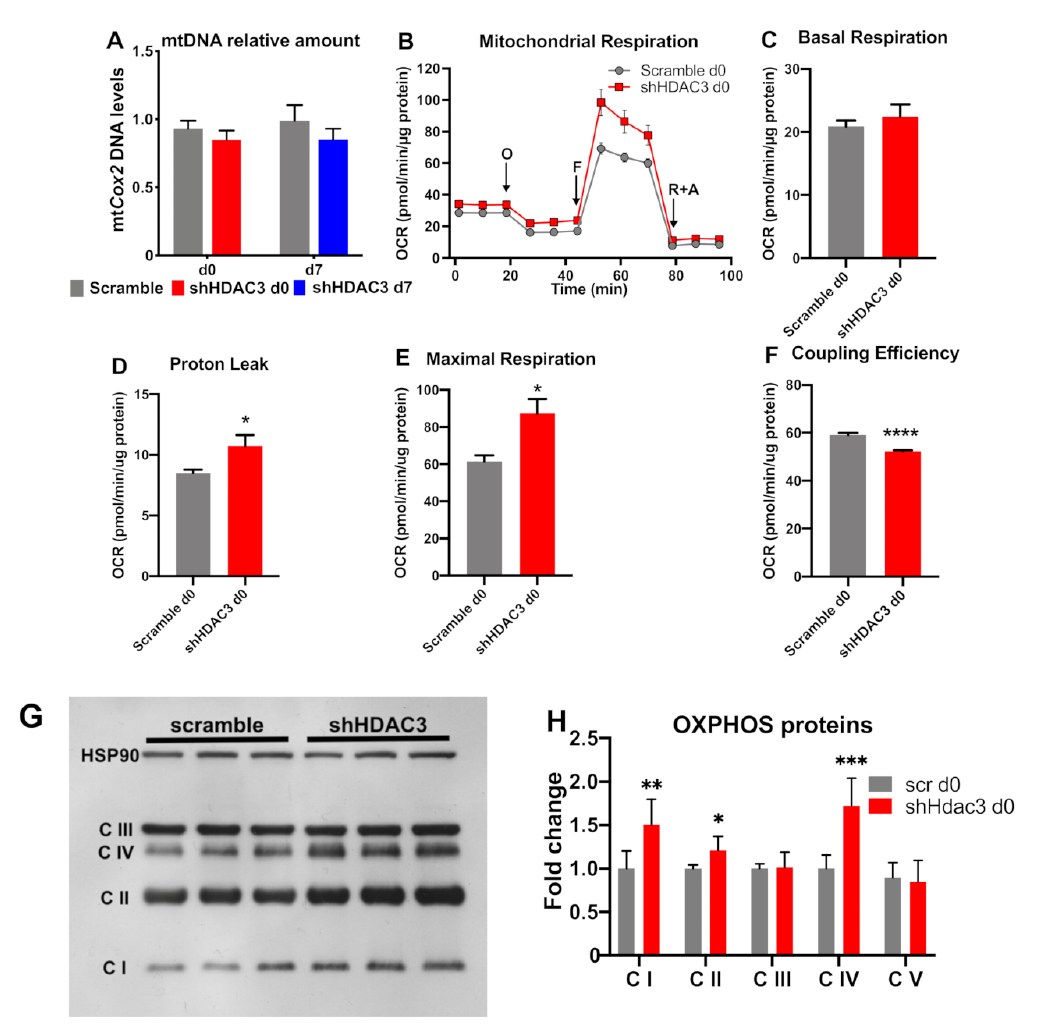
Figure 7. mtDNA levels and mitochondrial respiration in C3H/10T1/2 adipocytes infected with scramble/shHDAC3. ( A ) Cells silenced at day 0 were harvested at day 9 after induction of differentiation, while cells silenced at day 7 were harvested at day 11 after induction of differentiation ( n = 18 from 6 independent experiments). Cells silenced at day 0 were analyzed at day 9 after induction of differentiation for mitochondrial respiration (O, oligomycin addition; F, FCCP addition; rotenone + antimycin A addition) ( B ); basal respiration ( C ), proton leak ( D ), maximal respiration ( E ) and coupling efficiency ( F ) were calculated. Data are presented as mean ± SEM. Statistical analyses were performed with GraphPad PRISM and unpaired Student’s t -test, * p < 0.05 and **** p < 0.0001 ( n = 5). ( G ) Representative western blot of C3H/10T1/2 cells infected with scramble/shHDAC3 at d0 of differentiation to adipocytes to detect OXPHOS proteins: C I, complex I; C II, complex II; C III, complex III; C IV, complex IV; complex V (ATP synthase) was visible only at longer exposure of the film; however,